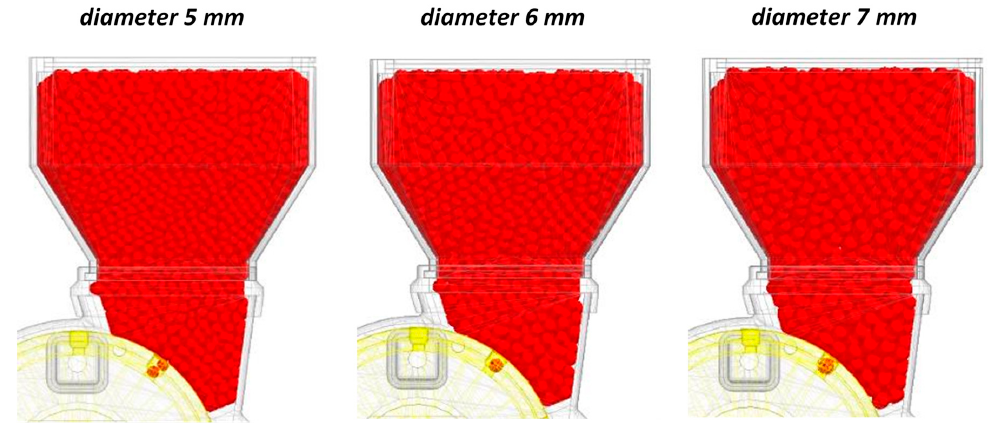
Figure 14. Simulation of the process of loading the seed hopper with pelleted seeds of various diameters.